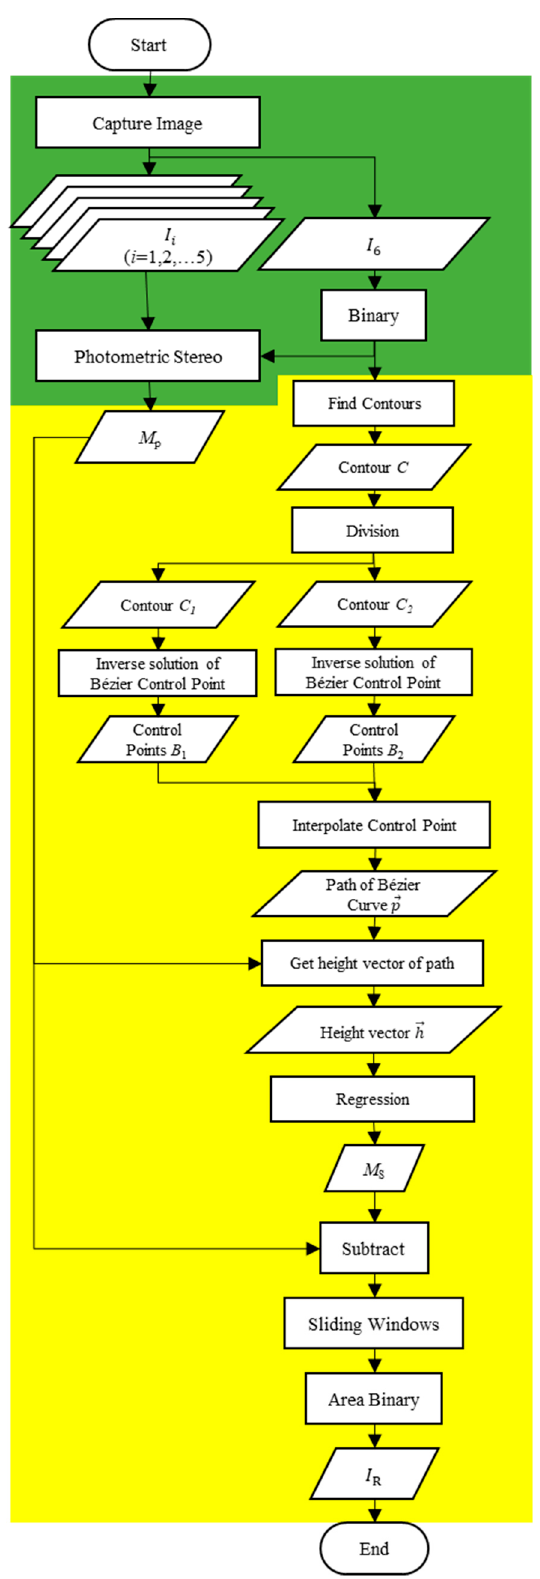
Figure 5. Flowchart of the O-rings defect detection process. The green region is image capture relative processing and the yellow region is defect detection relative processing. Which M P and I 6 replace with result of optical profilometer reconstruction when the verification stage.